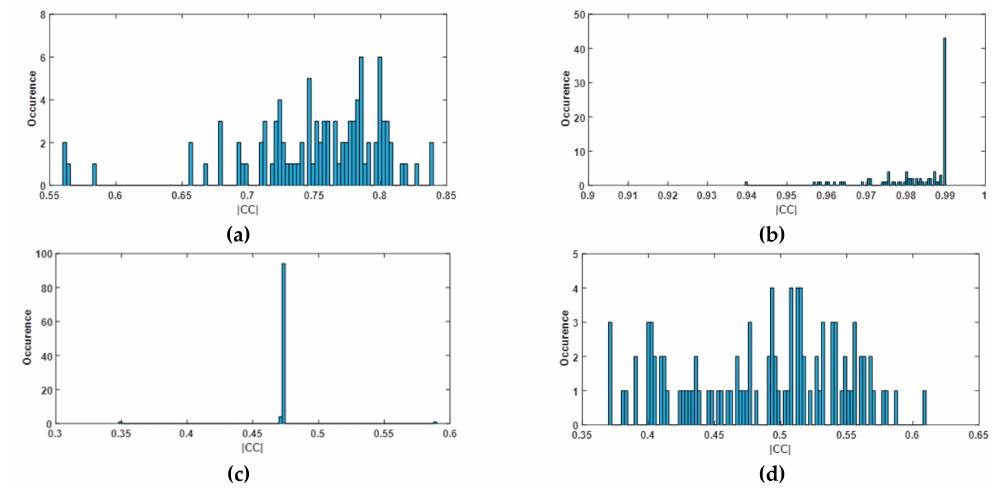
Figure 9. Histograms of the | CC | criterion values obtained by the tested methods: ( a ) Grd-Part-NMF, ( b ) Multi-Part-NMF, ( c ) Grd-NMF and ( d )